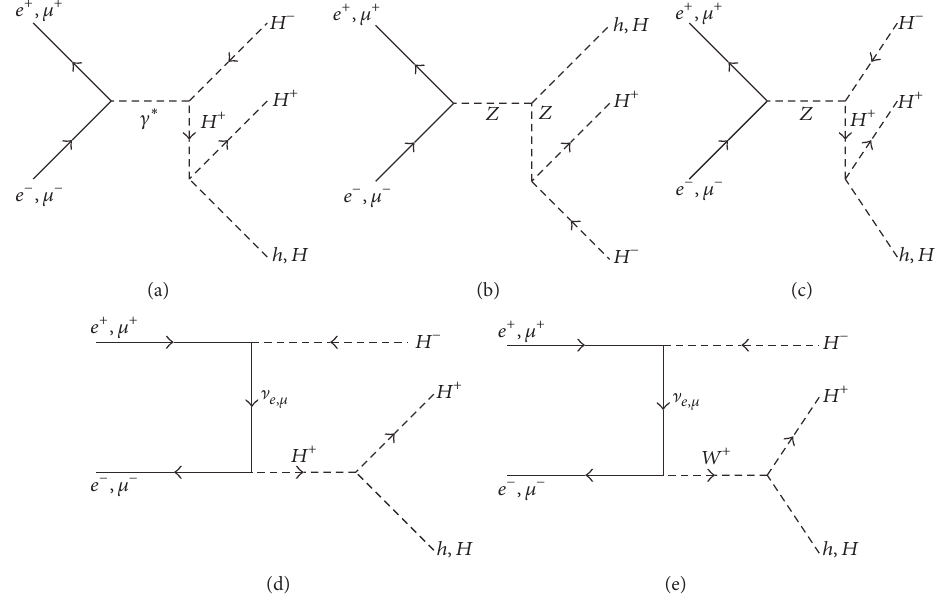
Figure 5: The possible Feynman diagrams for triple Higgs production at lepton colliders.